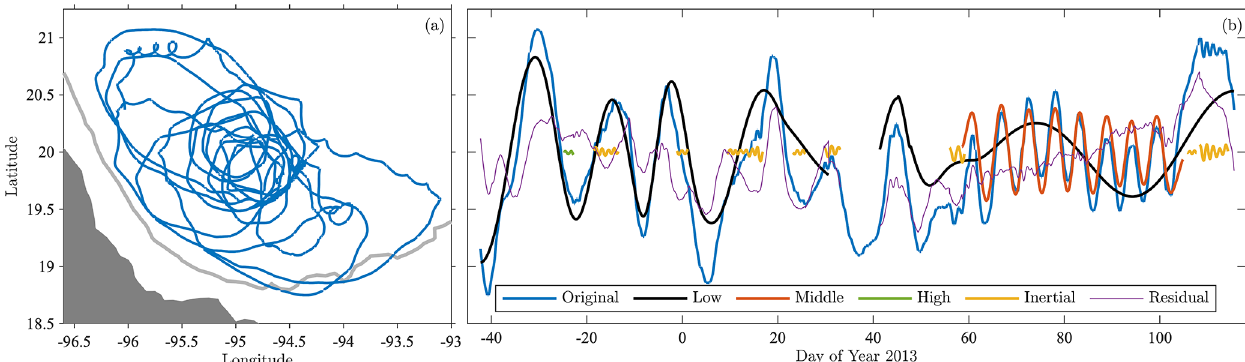
Figure 9. An example of a trajectory decomposed according to the unobserved components model of Eq. (38), using the one-sided wavelet ridge method. Panel (a) shows the trajectory of drifter ID #80348 from the SGOM experiment, in the Campeche Gyre in the southwestern Gulf of Mexico. The dark gray shading is the continent and the thick light gray line is the 500m isobath, as in Fig. 1. In panel (b) , the original latitude signal of this trajectory is shown, along with oscillatory signals extracted from low, medium, and high frequencies, as well as the inertial band. Also shown is the residual after adding up all the extracted signals and subtracting the result from the original, Eq. (59), converted back to a latitude. The origins of the various curves are shown in Fig.